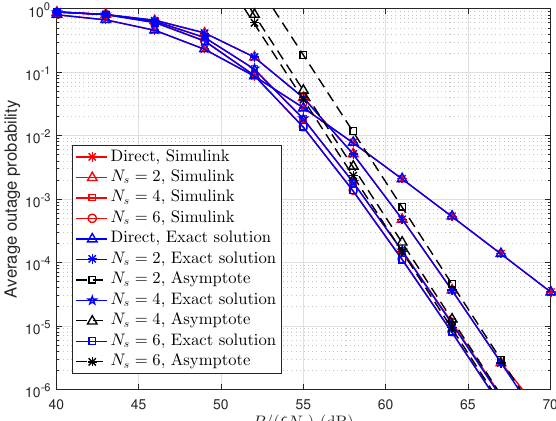
Figure 5. Comparison of simulation, exact and approximated average outage